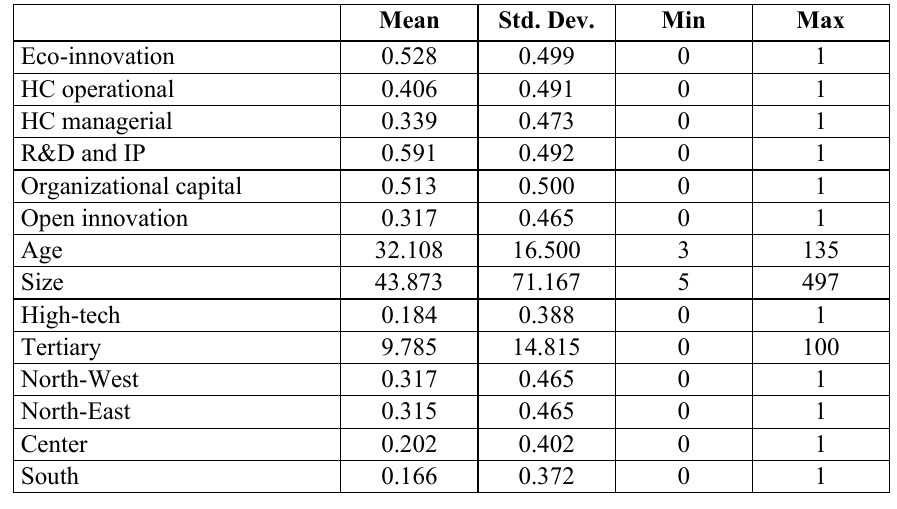
Table 2: Summary